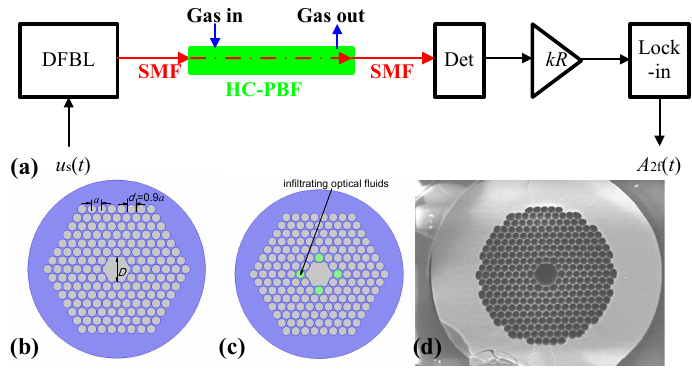
Figure 1. ( a ) Schematic of a hollow-core photonic band-gap fiber (HC-PBF)-based spectroscopic gas sensor. The sub-figures show ( b ) the cross-section structure by un-infiltrating optical fluids to the HC-PBF, and ( c ) the cross-section structure by infiltrating optical fluids into the selected air holes of the HC-PBF. ( d ) Scanning electron microscope (SEM) image of the HC-PBF commercially available from NKT optics.